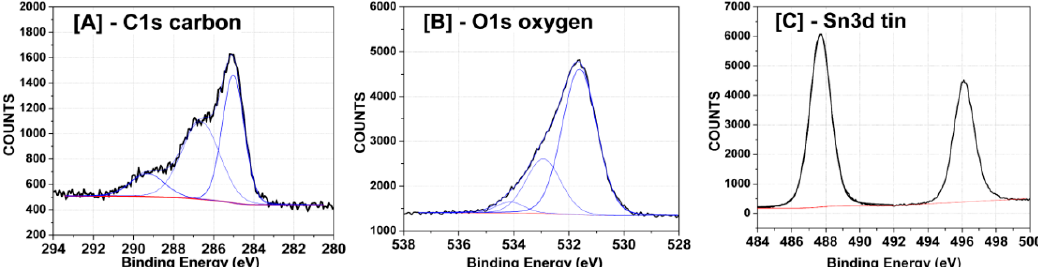
Figure 4. High-resolution XPS scans for the selected SnO 2 -graphene peaks assigned to ( A ) carbon; ( B ) oxygen; ( C ) tin. Peaks were fitted and deconvoluted using Hawk analysis software.